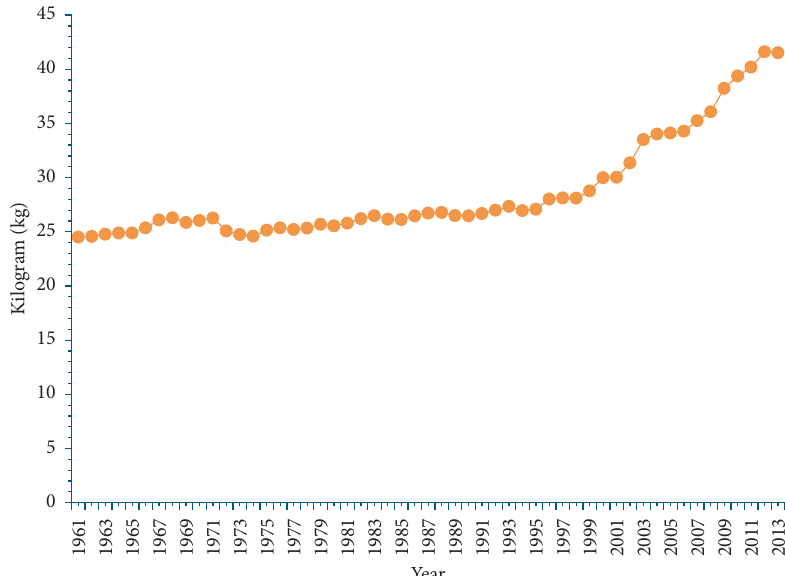
Figure 3: Trend in vegetable consumption per capita in the least developed countries, 1961 to 2013